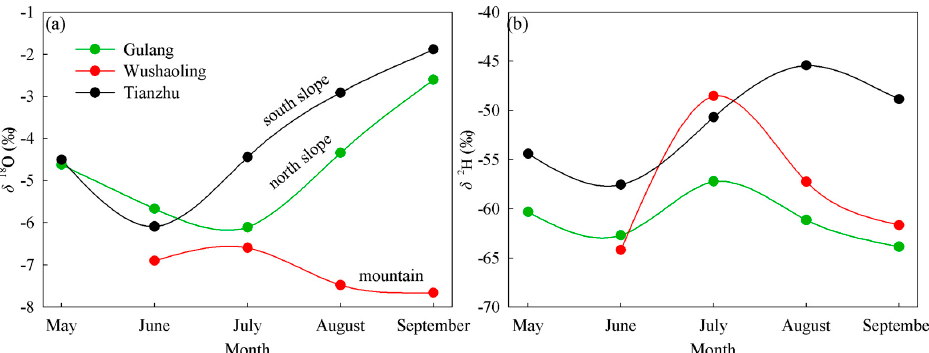
Figure 8. The monthly variations in stem water isotopes. ( a ) is δ 18 O variation and ( b ) is δ 2 H variation.